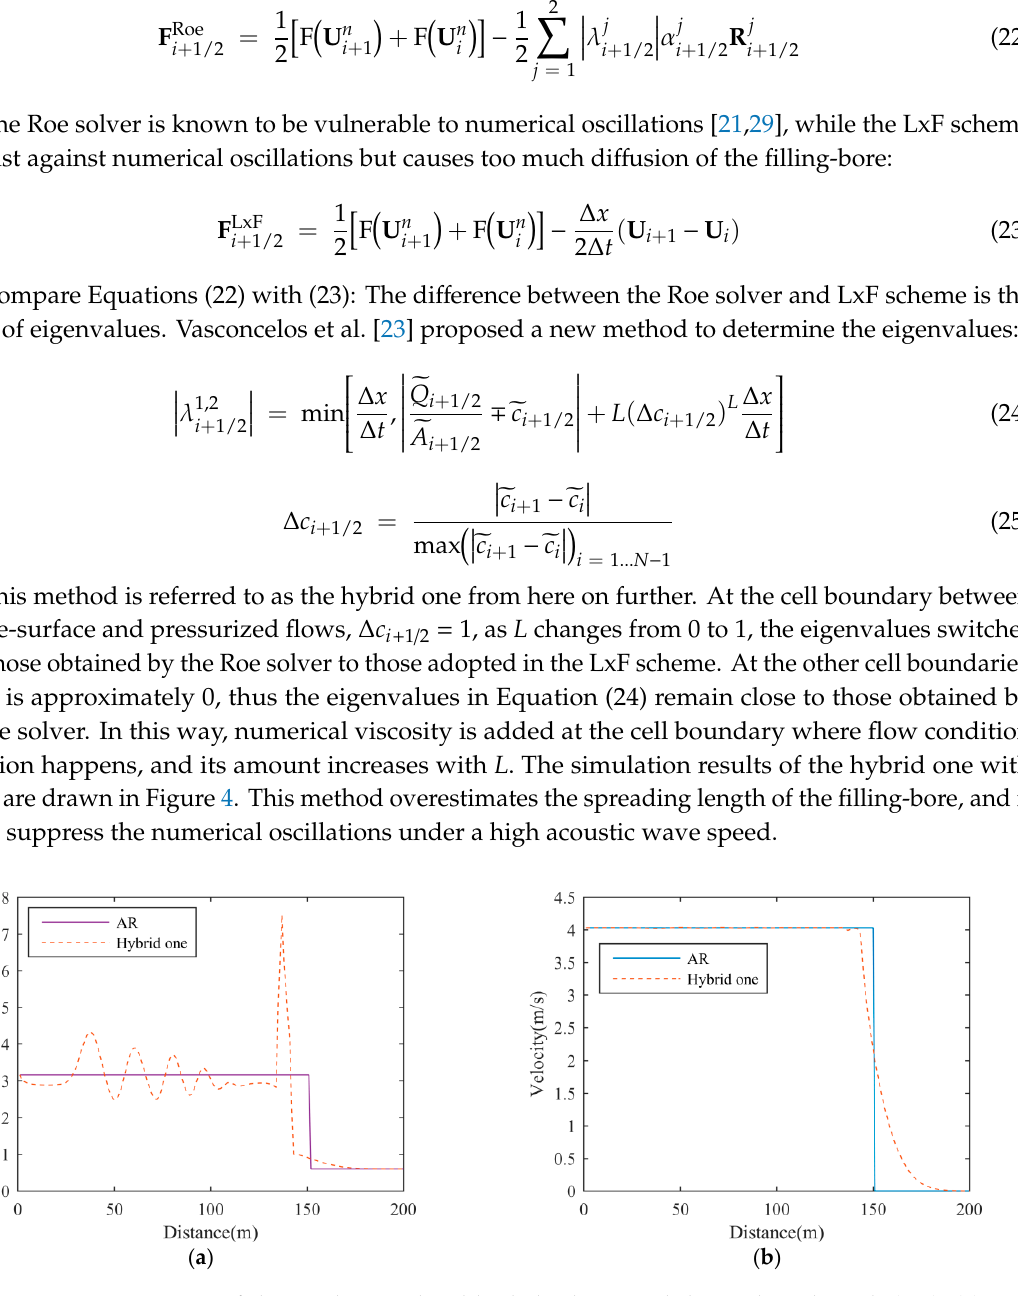
Figure 4. Comparison of the results simulated by hybrid one and the analytical result (AR): ( a ) piezometric head; ( b ) flow velocity.